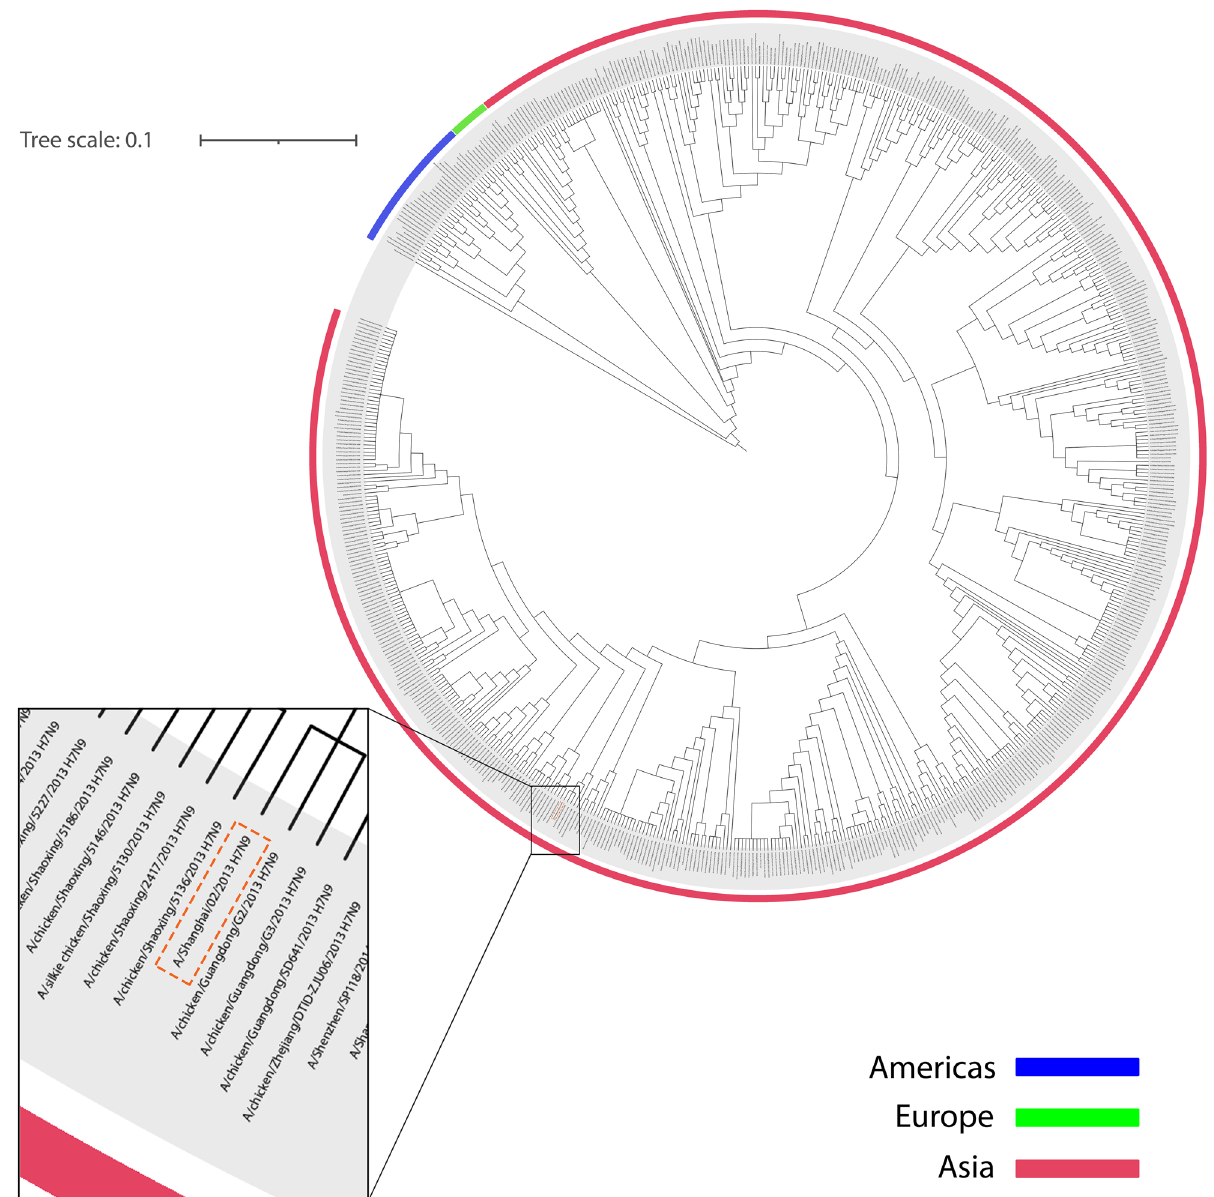
Figure 1. HA circular phylogenetic tree. The amino acid sequence of HA (A/Shanghai/2/2013 H7N9) was evaluated with other 642 (H7N9) HA amino acid-based on NCBI Influenza Virus Resource. The tree scale was considered equal to 0.1. All H7N9 HA proteins are related to human-derived, avian-derived and environment- derived. Spread H7N9 HA in the Americas, Europe and Asia are shown in blue, green and pink line, respectively. HA protein of A/Shanghai/2/2013 H7N9 has been magnified and specified in an orange dashed- line